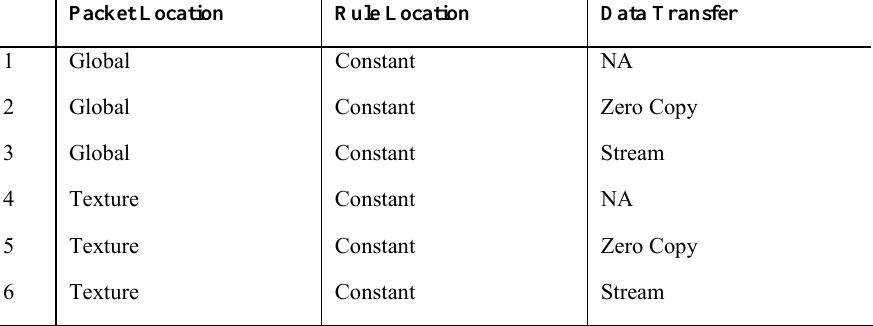
Table 4. Combination of various memory architectures for GPU-based BitMap-RFC